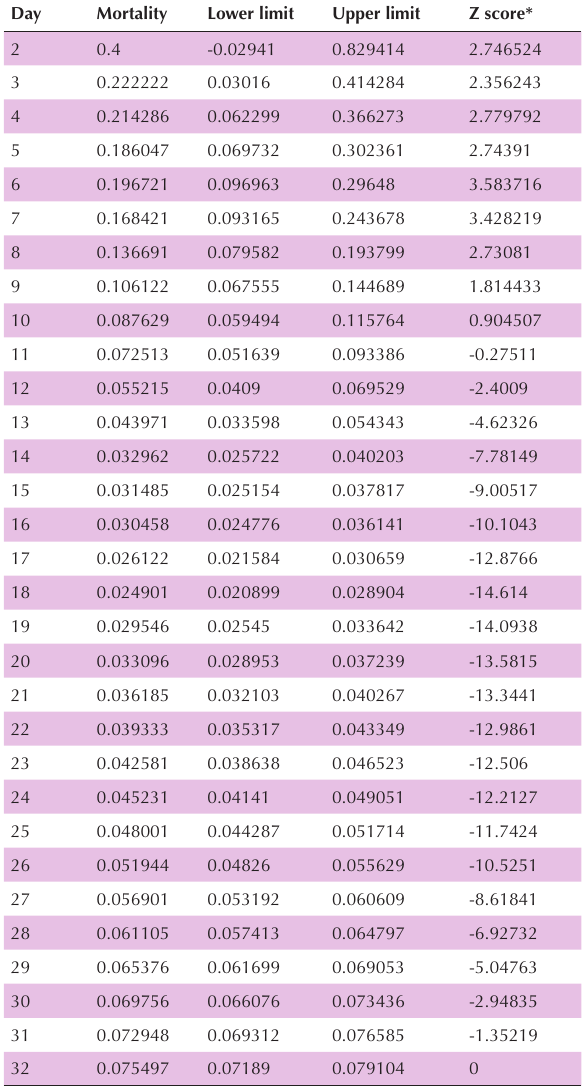
Table 1. Daily CFR of COVID-19 from day 2 of epidemics to day 32 Day Mortality